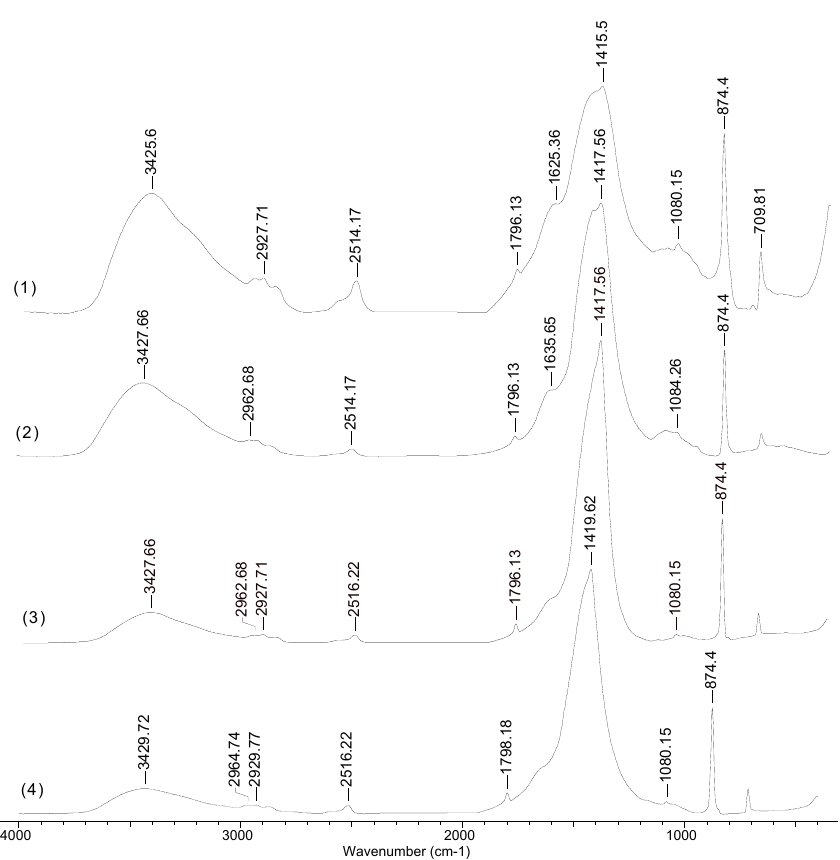
Figure 4. FTIR spectra of alginate, before ( 1 ) and after ( 2 ) Cu(II), ( 3 ) Co(II) and ( 4 ) Zn(II) ions biosorption, in optimal experimental conditions.